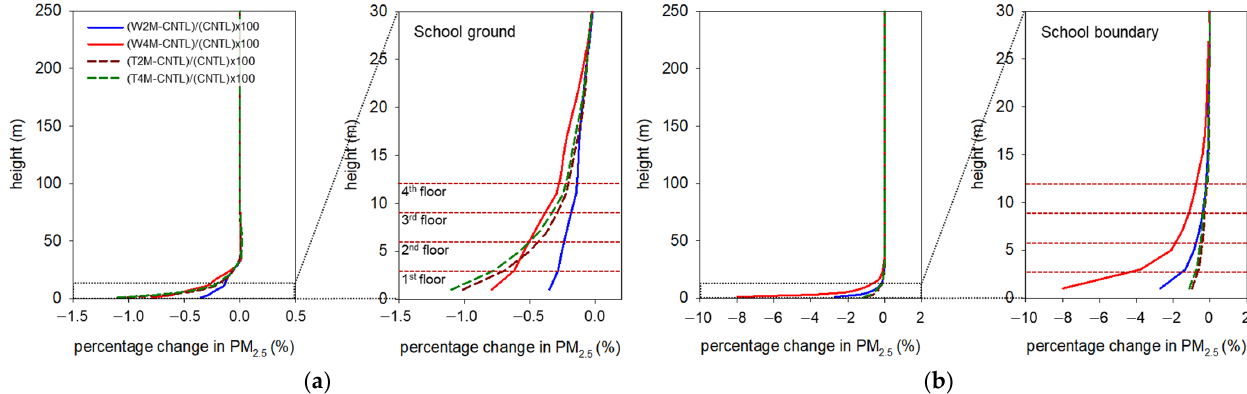
Figure 13. Vertical profiles of the PM 2.5 concentration change rates for each case compared to the CNTL case averaged for the 16 inflow directions in the ( a ) school ground and ( b ) school boundary. Table 5. Change rate of PM 2.5 concentration by the school building floor for each case compared to the CNTL case (%). The parentheses indicate the standard deviations of the PM 2.5 concentration calculated for 16 inflow directions.